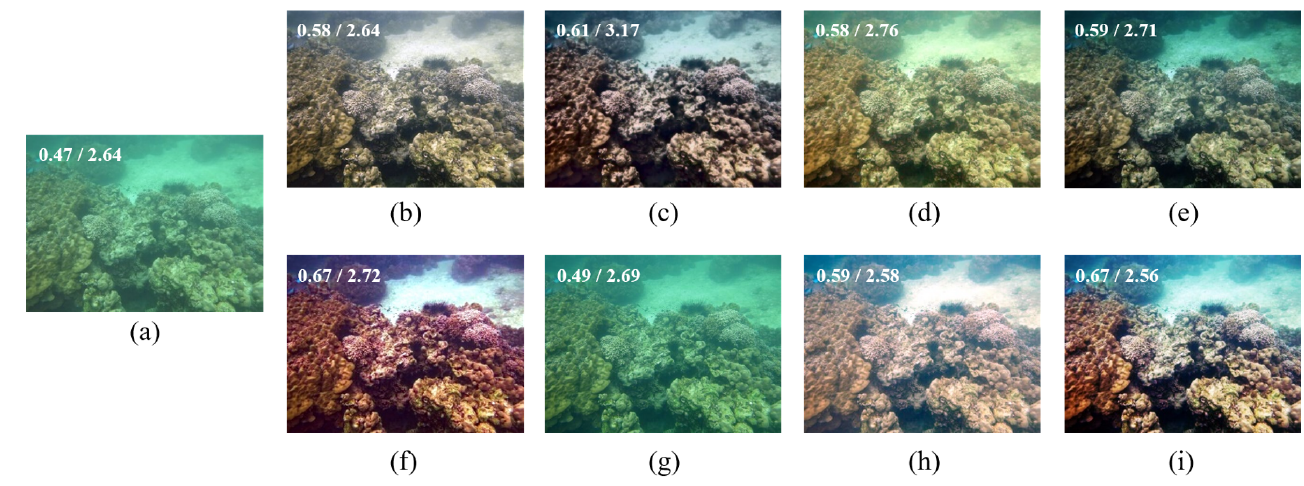
Figure 7. ( a ) Greenish underwater image, and its restored/enhanced results obtained using ( b ) Fusion-based[43], ( c ) Retinex-based[44], ( d ) IBLA[10], ( e ) AGC[45], ( f ) GDCP[9], ( g ) UWCNN[26], ( h ) BL-TM[40], and ( i ) the proposed method. The number on the top-left corner of each image refers to its UCIQE/NIQE score.